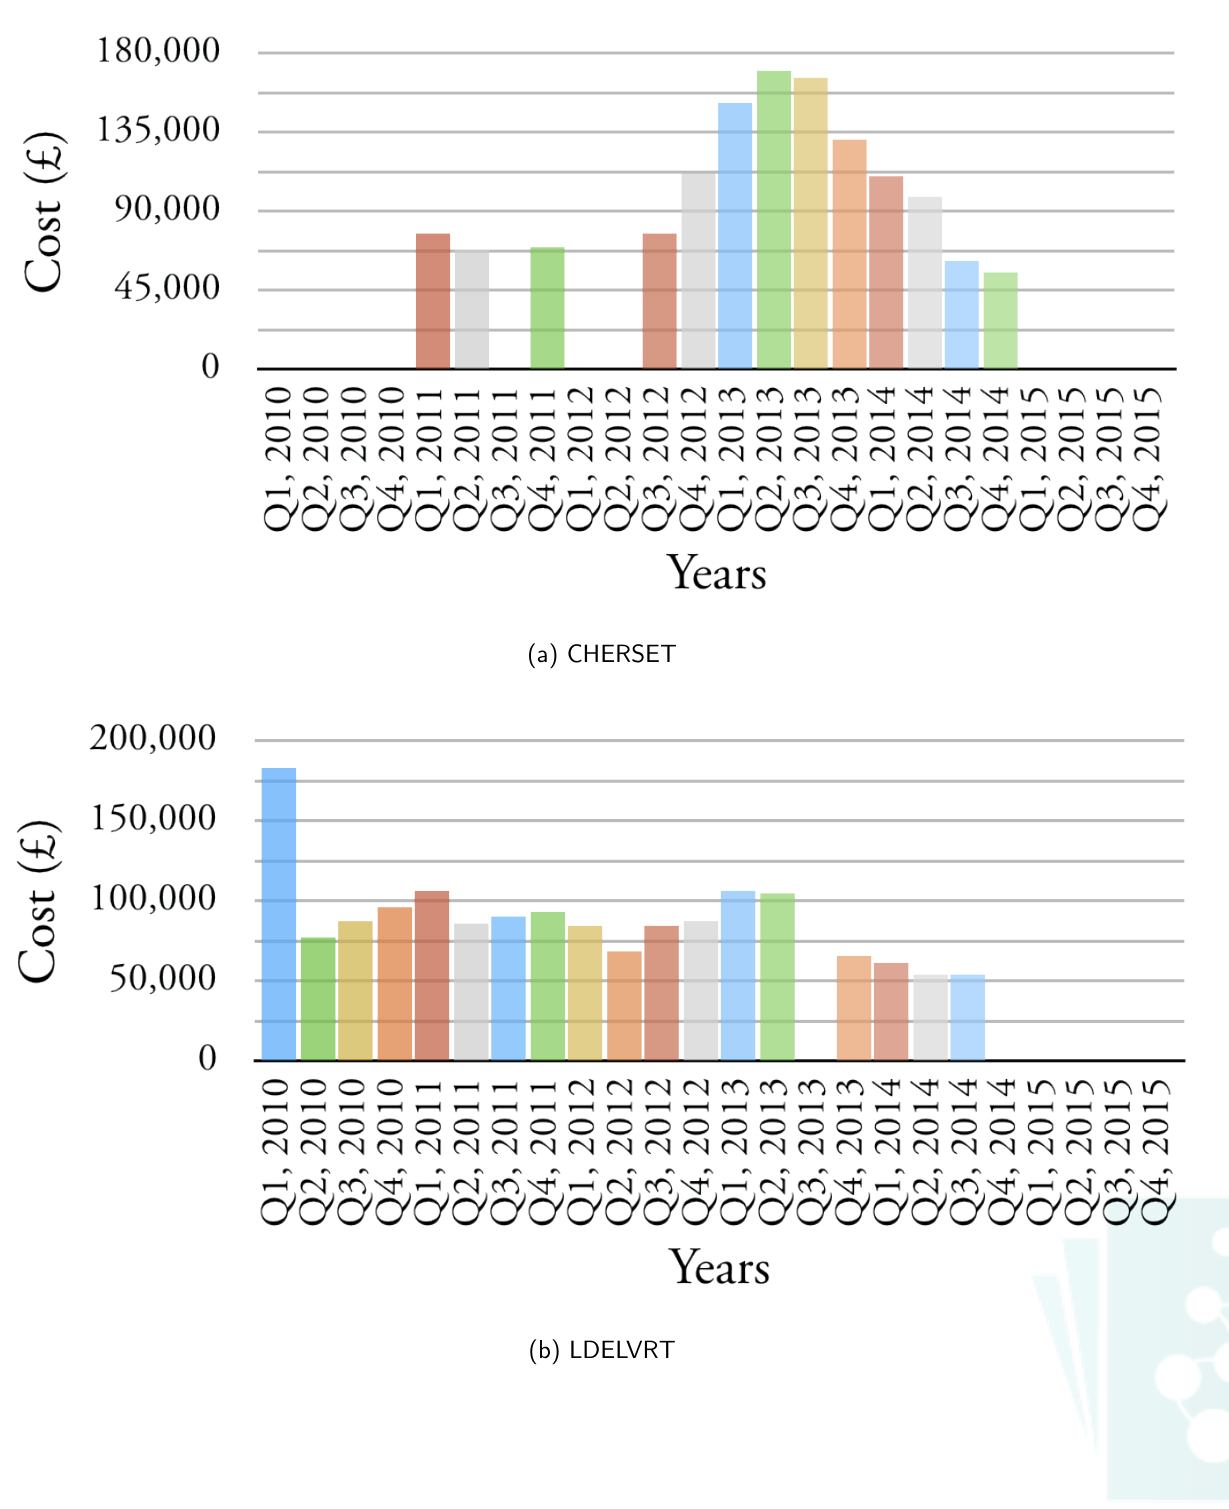
Figure 5: Example of anomalies that the exploration of data